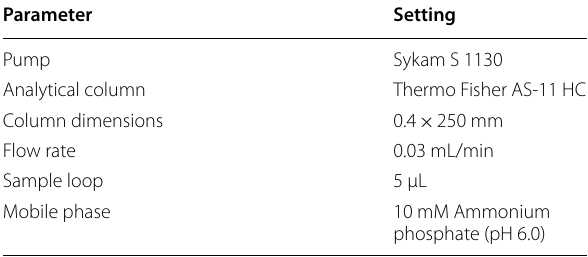
Table 1 Operating parameters of IC using the capillary column